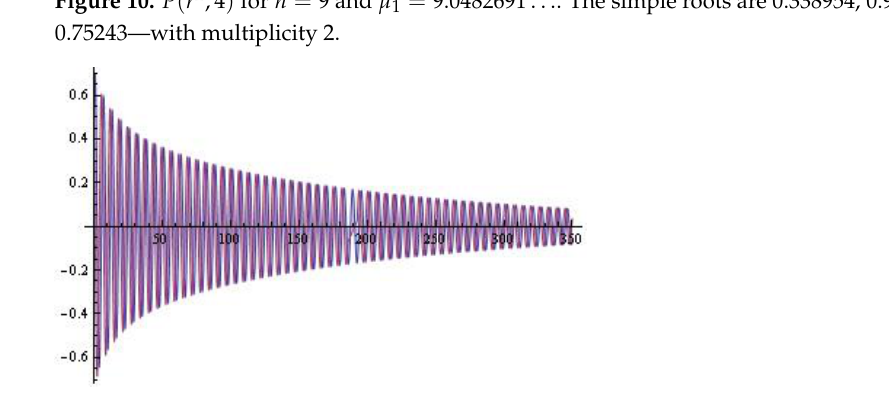
Figure 11. The solutions of the system (10) ( (cid:101) = 0.001; n = 9; µ 1 =